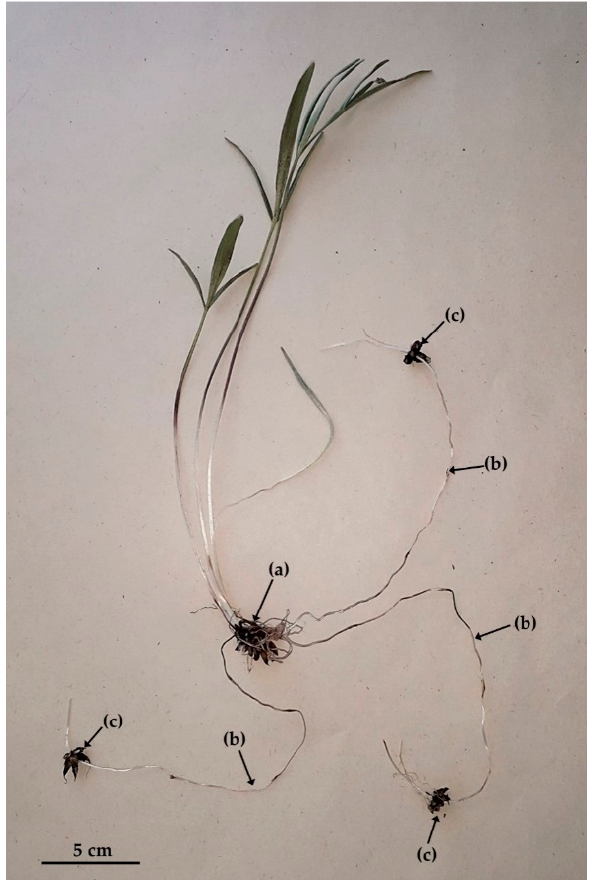
Figure 3. Vegetatively reproducing individual of Ranunculus illyricus : ( a ) mother cluster of tubers with aboveground shoot, ( b ) underground stolons, ( c ) progeny clusters of tubers. At the end of June, the whole aboveground part, the unmodified roots, and the underground stolons connecting the clusters of mother tubers with the progeny die. The plant takes the form of a cluster of tubers with a dormant perennating bud on top (Figure 2a). Dormancy occurs in summer until the beginning of autumn (July–September) and lasts for at least three months. At the end of September, new roots emerge at the base of the regenerating bud, followed by underground shoots. The dormant bud meristem